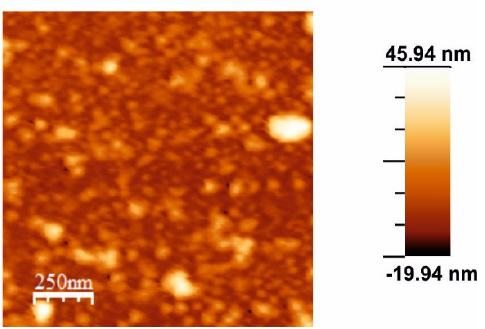
Figure 4. AFM topographic 2D images of a LbL film formed by [CHI-IL/CuPc S ] 12 film.